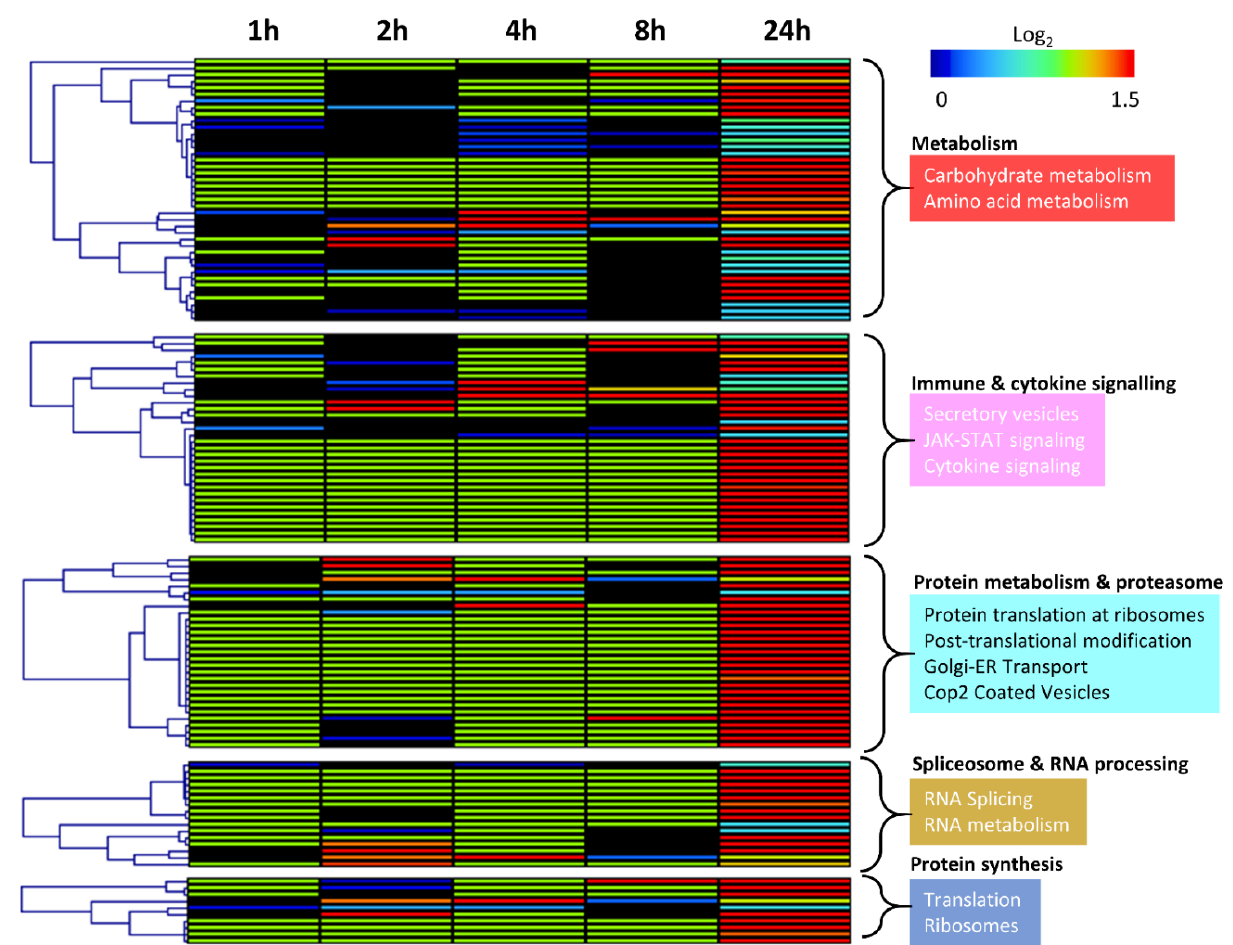
Figure 4. Comparison of secreted protein level by enriched pathways across all timepoints. Heatmap is based on log 2 secretion levels following 2 Gy of radiation at 1, 2, 4, 8 and 24 h compared to untreated controls at each timepoint in respect of pathways enriched in the radiation-induced secretome. Functional enrichment was performed in STRING using the KEGG [41] and Reactome [42,43] databases. Clustering of proteins is based on Pearson correlation with average linkage. Heatmap colours denote log 2 change in secretion level compared to untreated controls at each time point as denoted by the colour bar.